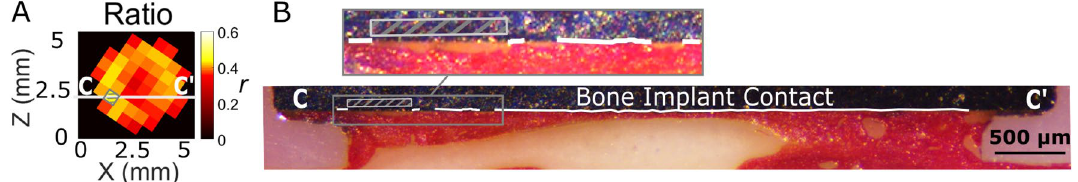
Figure 8. ( A ) Spatial variation of r obtained for a sample belonging to the group S-13 (same as Fig. 3). ( B ) Corresponding histologic slice (in the C–C’ plane) with stained bone tissue in red. The white line corresponds to the locations where bone is in contact with the implant. The grey cross-hatched region (in A and B ) corresponds to a region of interest where no bone is in contact with the implant, as observed in the histological slice ( B ) and confirmed with higher values of r ( A